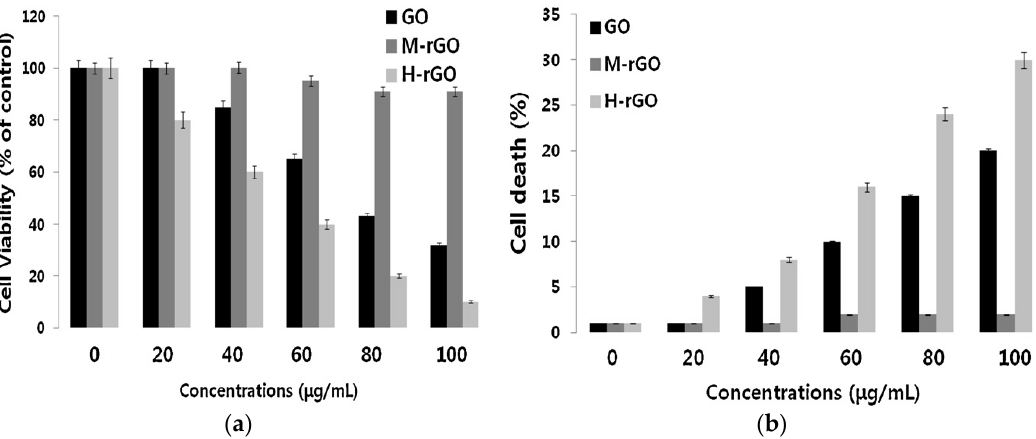
Figure 16. ( a ) WST-8 assay for primary mouse embryonic fibroblasts exposed to GO, M-rGO, and H-rGO of different concentrations for 24 h. Error bars represent standard error of the mean ( n = 3); p < 0.05; ( b ) Cell mortality of primary mouse embryonic fibroblasts (PMEF) cells determined from trypan blue assay upon 24-h exposure to GO, M-rGO and H-rGO of different concentrations. Error bars represent standard error of the mean ( n = 3); p < 0.05. Reproduced from [124] with permission of Elsevier.